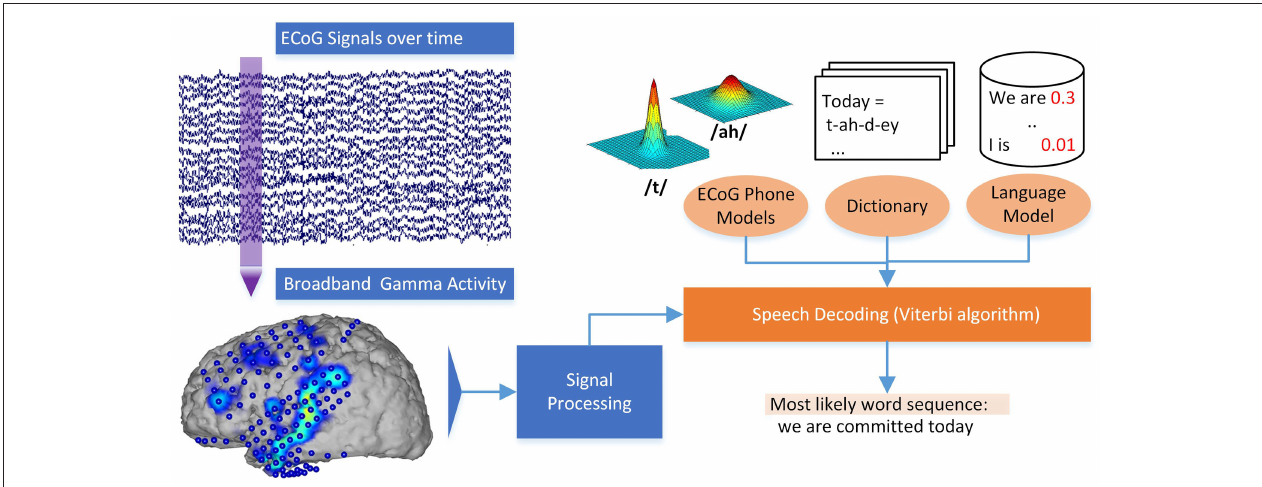
FIGURE 2 | Decoding process in the Brain-to-text system. Broadband gamma power is extracted for a phrase of ECoG data. The most likely word sequence is then decoded by combining the knowledge of ECoG phone models, dictionary and language model.